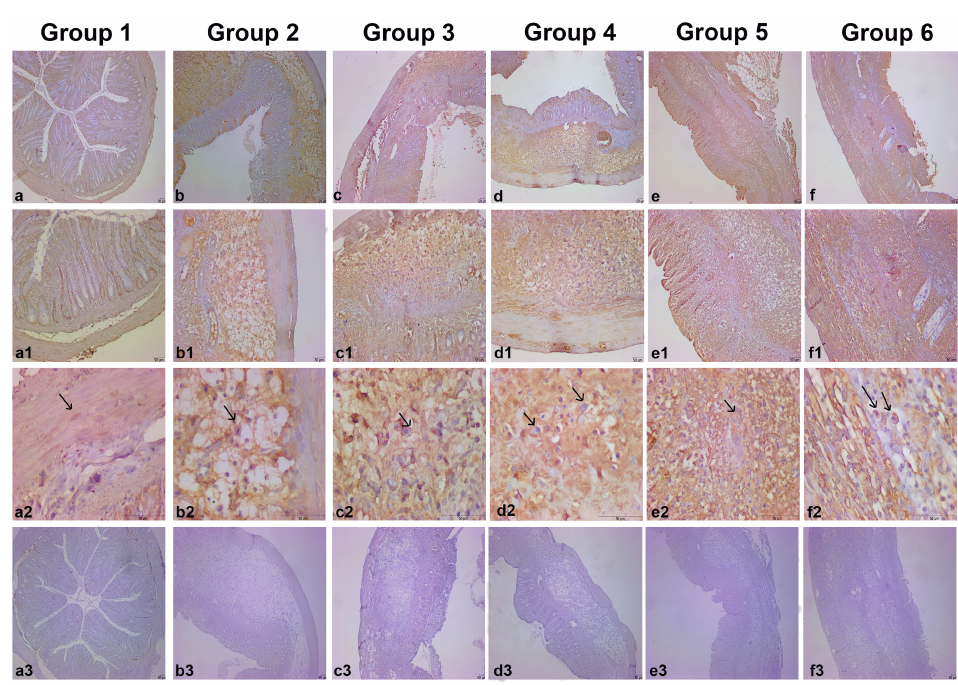
Figure 5. PGP 9.5 immunohistochemistry in colon descendens of experimental groups. Scale bars: 50 µm. (a-f) 40 × , (a1-f1) 100 × , (a2-f2) 400 × magnification. (a3-f3) 40 × magnification and show isotype controls. Black arrows show ganglion